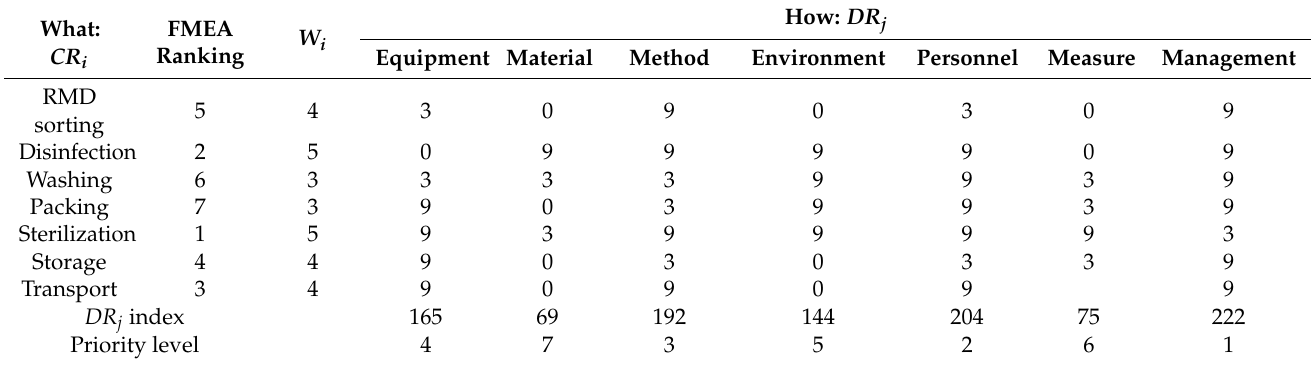
Table 4. QFD matrix (house of